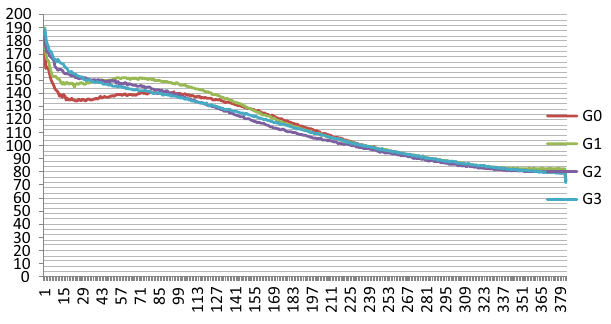
Fig. 7. PS of the images of grades 0, 1, 2, 3.